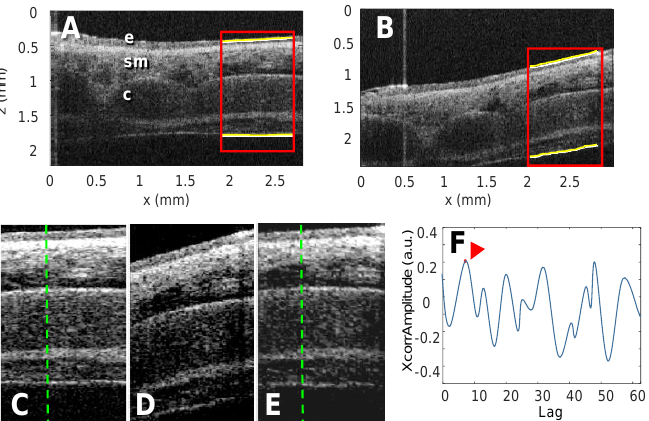
Figure 11. ( A , B ) The original OCT images of freshly excised trachea, at different incidence angles. The labels refer to the epithelium (e), the submucosa (sm) and cartilage (c). ( C ) The portion of image ( A ). ( D ) Portion of image ( B ). ( E ) The registered version of ( D ). ( F ) The cross-correlation of the A-scans indicated by the dashed lines in ( C , E ). The arrow points to the first maximum after the zero lag (not shown here for better visualization of the peaks) [166].